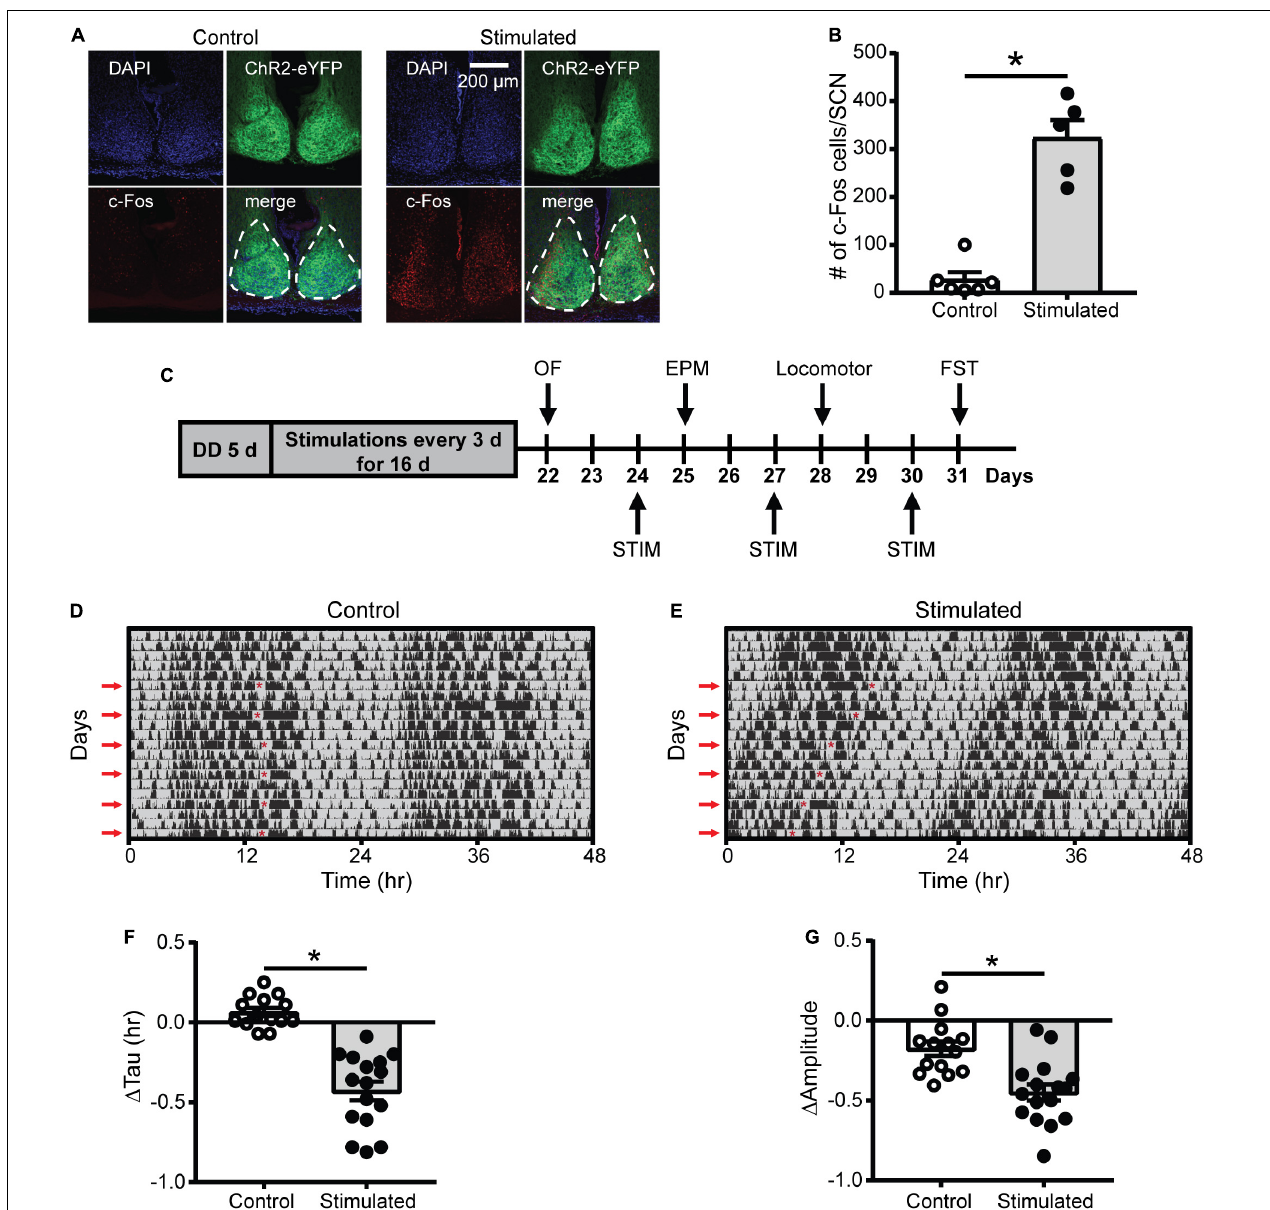
FIGURE 1 | Effects of SCN stimulation at CT21 on c-Fos cells in the SCN and homecage activity rhythms. (A) Representative confocal images of coronal mouse brain slices containing the SCN from a control and stimulated mouse. (B) The average number of c-Fos-positive cells per mouse SCN were increased after stimulation at CT21. n = 5–6 mice. (C) Experimental design to determine the effects of repeated SCN stimulation at CT21 on psychiatric-related behaviors. STIM, stimulation. (D,E) Representative double-plotted actograms of homecage activity of a control and stimulated mouse. Gray shading indicates when lights were off and red arrows indicate the days when stimulations or sham stimulations occurred at CT21. The red asterisks on the left sides of the actograms indicate the times of the stimulations. Change in homecage activity circadian parameters were measured relative to baseline in DD. (F) Stimulated mice exhibited a greater reduction in homecage activity period or tau. (G) Stimulated mice showed a greater decrease in homecage activity amplitude. n = 14–16 Vgat -Cre;ChR2 mice. * p <